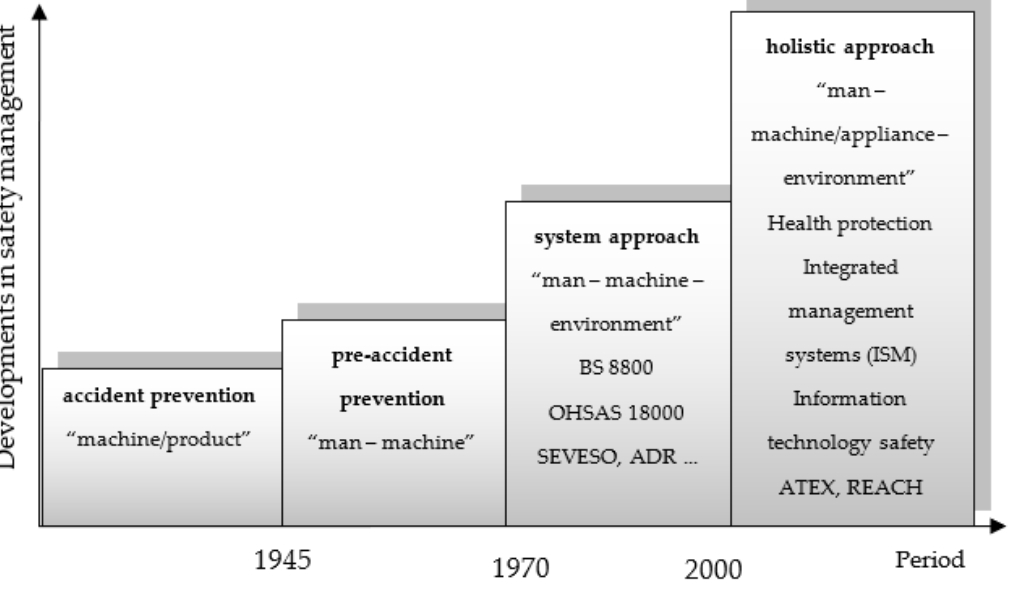
Figure 1. Development of safety management [5].